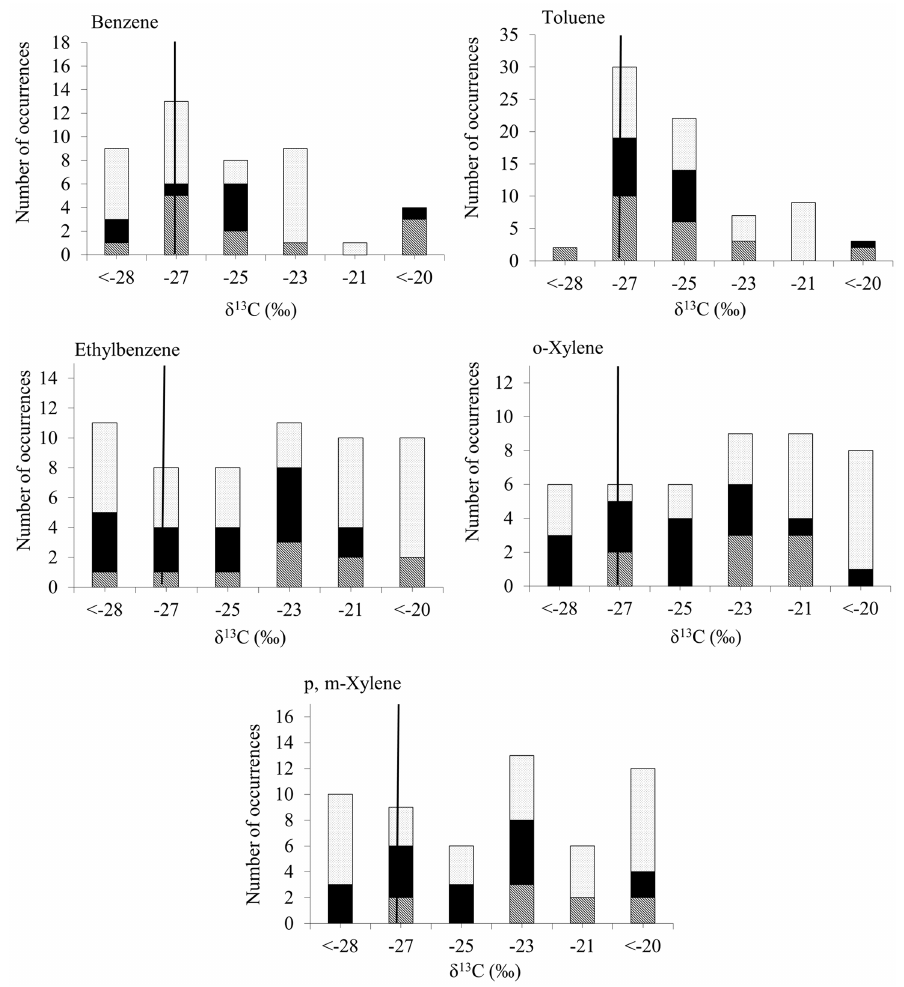
Figure 3. Frequency distribution for VOC carbon isotope ratios measured in Toronto in 2009 and 2010. Observations for different seasons are identified as follows: fall – dotted; winter – black; spring and summer – hatched. The solid vertical lines are the isotope composition of traffic-related emissions (Rudolph et al., 2002).